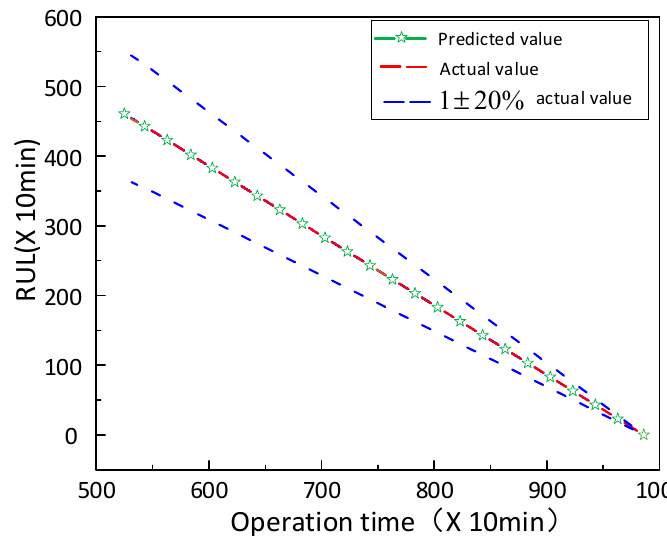
Figure 9. HI prediction start from different times, ( a ) T = 5350 min, ( b ) T = 7040 min, ( c ) T = 8500 min.